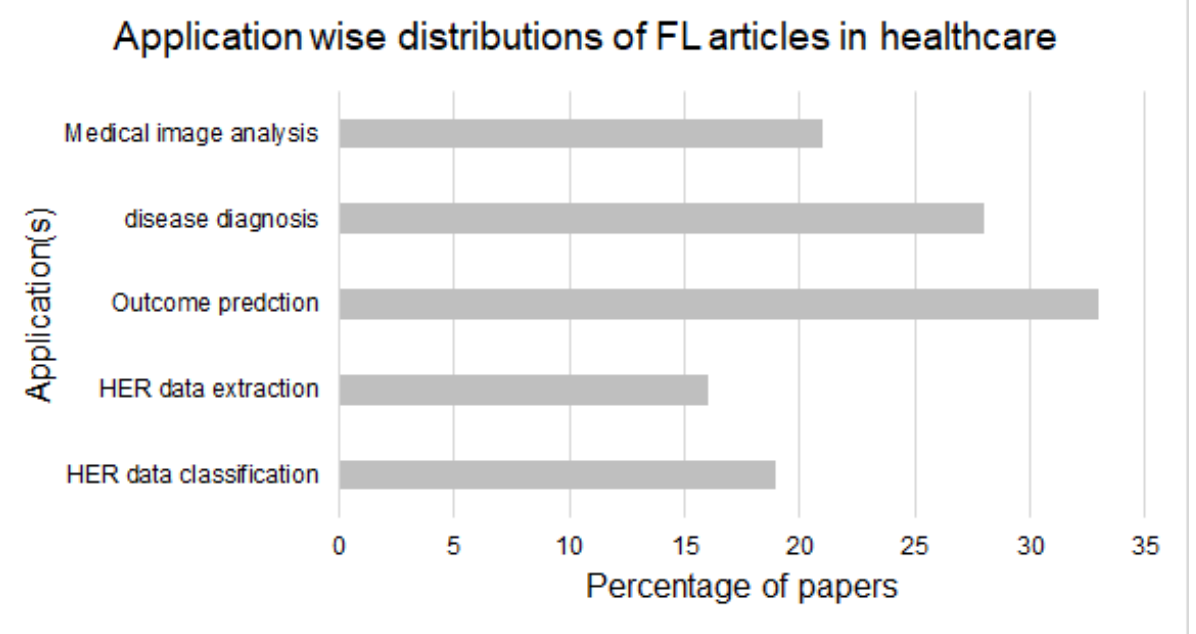
Figure 4. Overview of the FL applications in healthcare (Adopted from